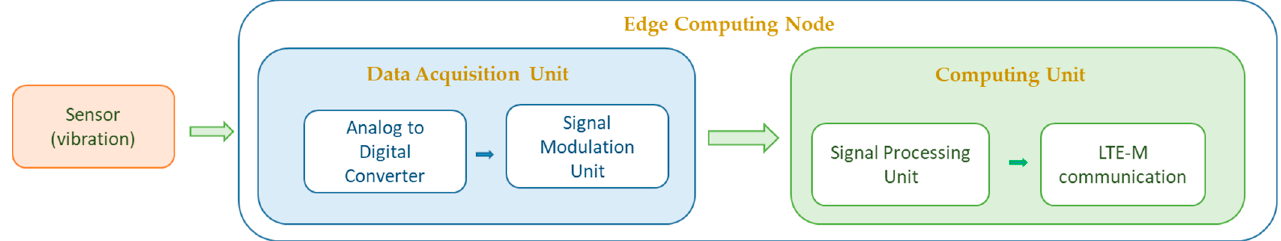
Figure 2. Node design architecture.